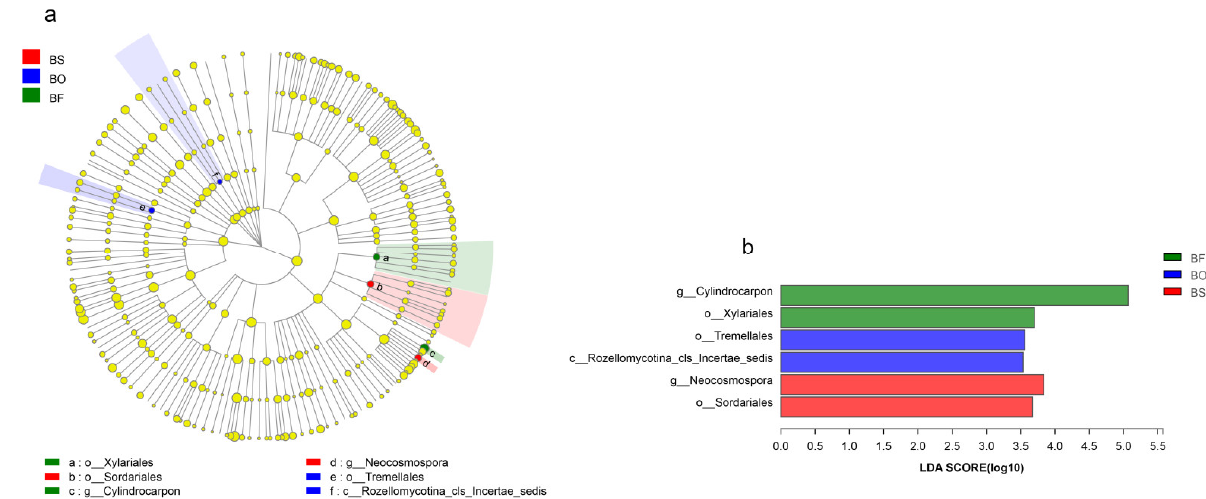
Figure 5. Cladogram showing the phylogenetic distribution of mycorrhizal fungi associated with different species of Bletilla ( a ). Indicator fungi with LDA scores of 2 or greater in mycorrhizal fungi associated with different Bletilla species ( b ). Differently coloured regions represent different Bletilla species (green, B. formosana ; blue, B. ochracea ; red, B. striata ). Circles indicate phylogenetic levels from phyla to genus. The diameter of each circle is proportional to the abundance of the group. BS, B. striata ; BO, B. ochracea ; BF, B. formosana